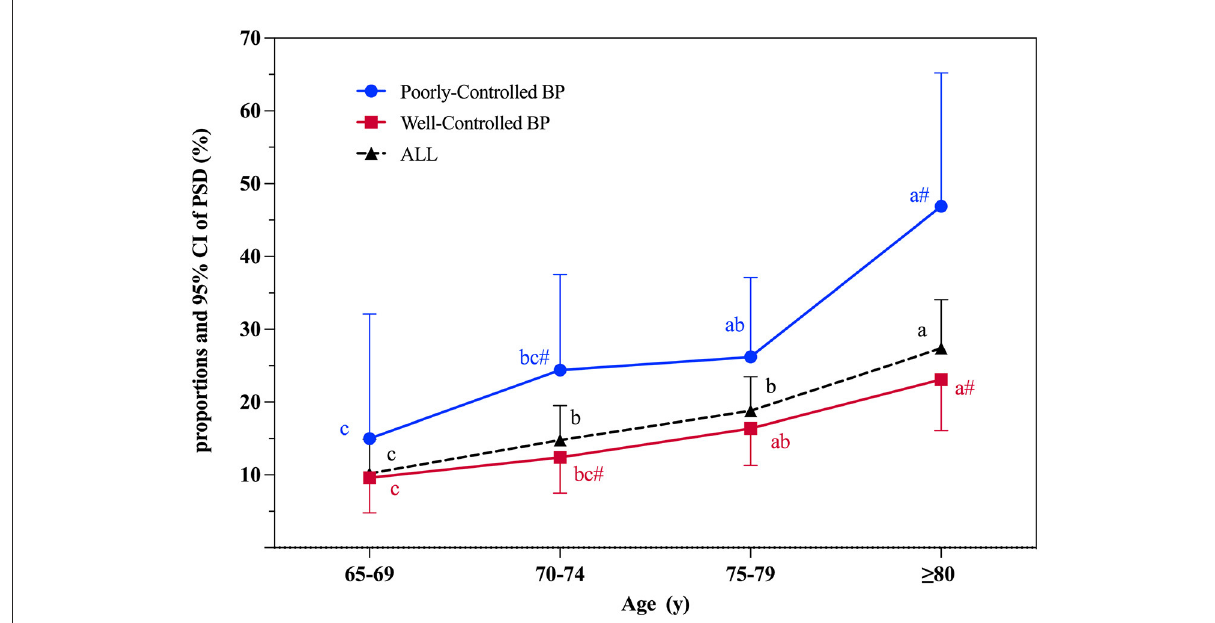
FIGURE2 Proportions and 95% CI of PSD according to age at interview. PSD, post-stroke dementia; BP, blood pressure control; 95% CI, 95% confidence interval. Significant differences between well-controlled and poorly-controlled BP groups: # indicates P < 0.05. The PSD proportion between different age groups was compared. Used abc letters as the mark letters. If the mark letters are the same, the difference is not significant. If the mark letters are different, the difference is significant ( P < 0.05).